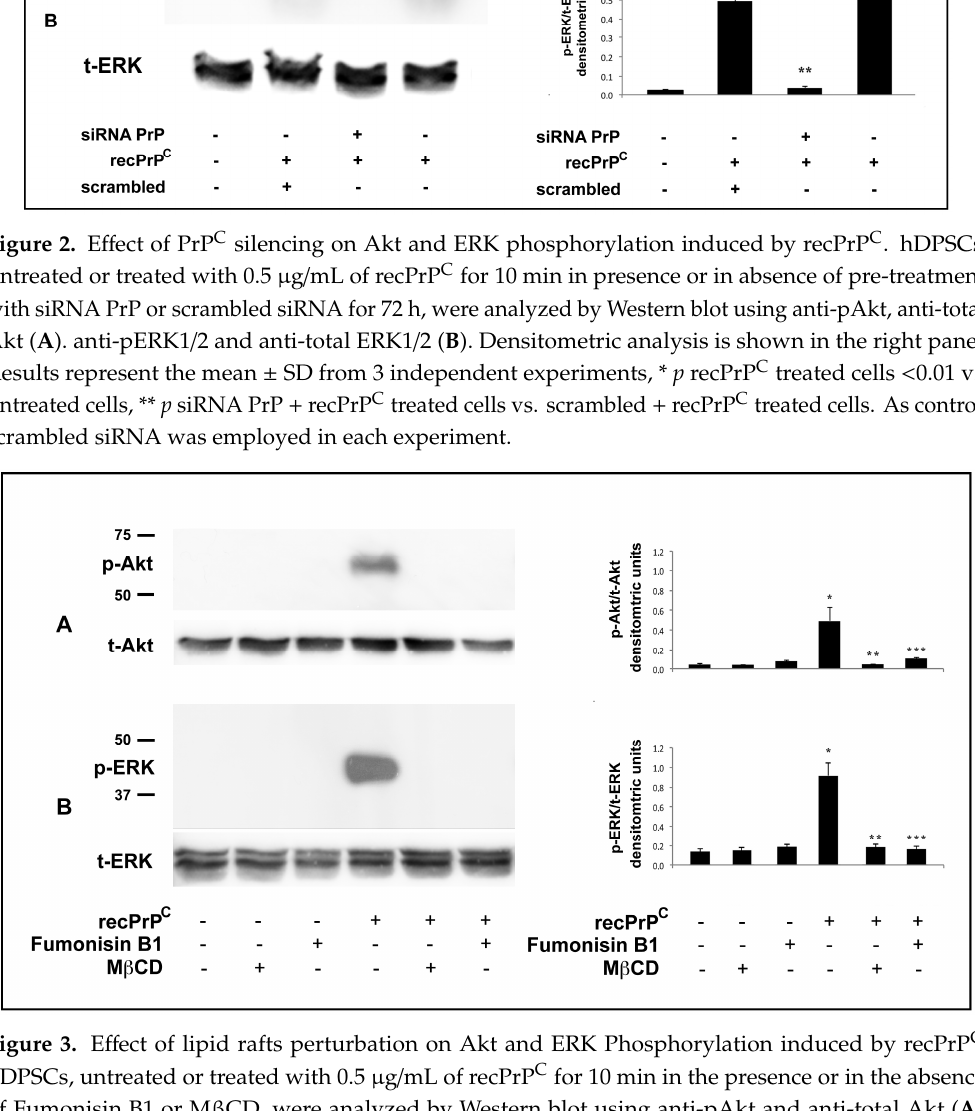
Figure 2. Effect of PrP C silencing on Akt and ERK phosphorylation induced by recPrP C . hDPSCs, untreated or treated with 0.5 µg/mL of recPrP C for 10 min in presence or in absence of pre-treatment with siRNA PrP or scrambled siRNA for 72 h, were analyzed by Western blot using anti-pAkt, anti- total Akt ( A ), anti-pERK1/2 and anti-total ERK1/2 ( B ). Densitometric analysis is shown in the right panel. Results represent the mean ± SD from 3 independent experiments, * p recPrP C treated cells <0.01 vs. untreated cells, ** p siRNA PrP + recPrP C treated cells vs. scrambled + recPrP C treated cells. As control, scrambled siRNA was employed in each experiment.